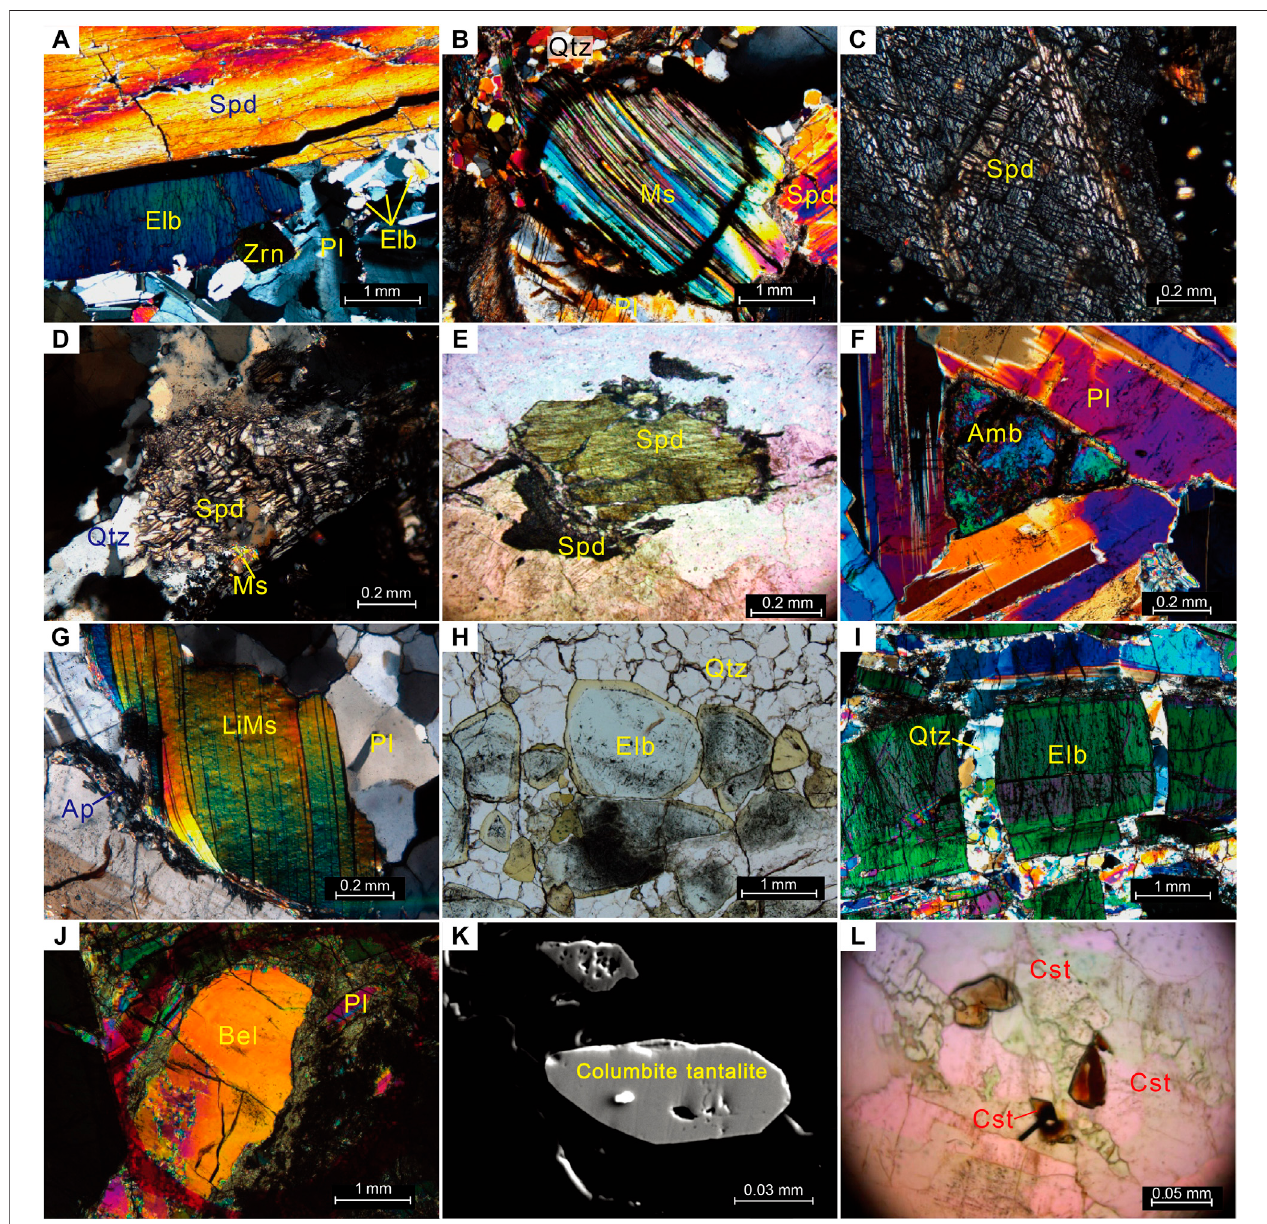
FIGURE 11 | Photomicrographs of samples from the Dahongliutan area showing: (A) example of spodumene-bearing pegmatite containing, elbaite, plagioclase and minor zircon; (B) spodumene-bearing pegmatite dykes consisting of muscovite, plagioclase and quartz; (C) cleaved spodumene; (D) quartz and muscovite fi lling fractures in spodumene; (E) late fi brous spodumene crystallised on the edge of early columnar spodumene; (F) a small amount of 0.2 -1 mm wide allomorphic and granular amblygonite associated with spodumene and plagioclase; (G) lithium-bearing, 1 and 5 mm long muscovite with a low and high refractive index; (H) two forms of light green elbaite; (I) dark green and columnar elbaite crossed by quartz and muscovite; (J) example of rare beryl; (K) back-scatter electron (BSE) image of tabular, 0.04-0.20mm longirregular and granularcolumbite-tantalite with asemimetallic luster;and (L) semi-automorphictoallomorphic granular0.1 and 0.2mm long cassiterite associated with the early spodumene. Abbreviations: Spd, spodumene; Qtz, quartz; Ms, muscovite; LiMs, lithium-bearing muscovite; Pl, plagioclase; Ab, albite; Amb, amblygonite; Zrn, zircon; Ap, apatite; Tur, tourmaline; Elb, elbaite; Bel, beryl; Cst, cassiterite.